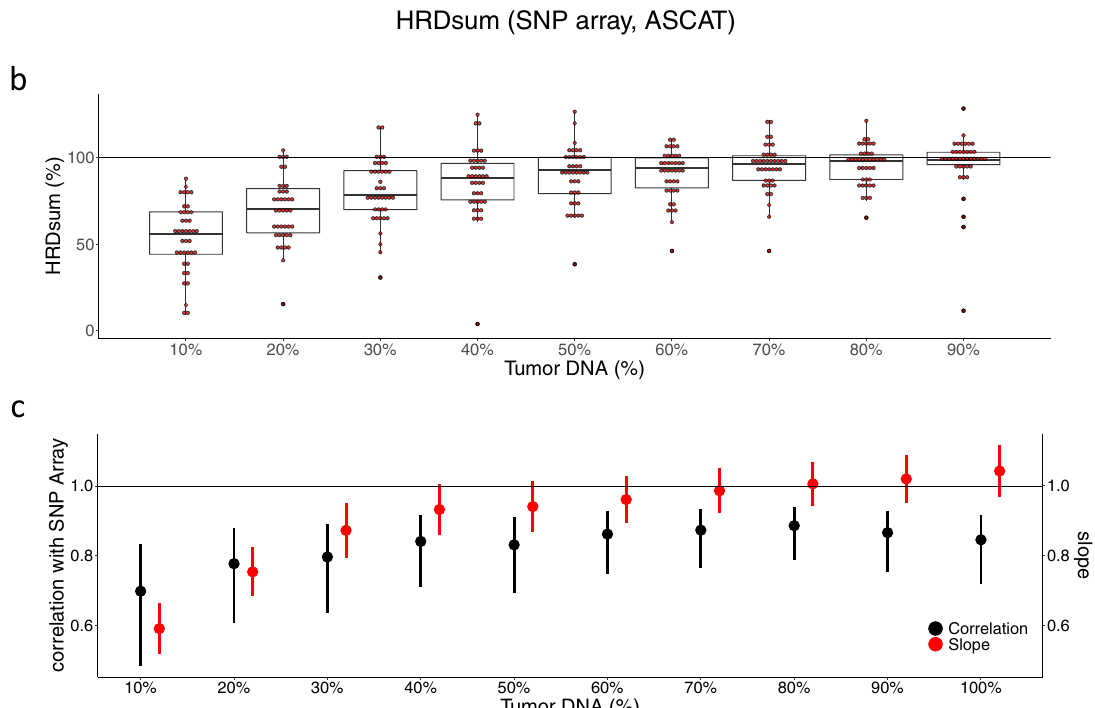
Fig. 6 Validation of HRDsum scores calculated from WES for the TCGA ovarian carcinoma cohort. a Correlation of HRDsum between WES and SNP array data. Each tumor is colored according to the HRR gene mutation class H1-H3. Linear fi t with intercept fi xed at zero. R = Pearson correlation. b/c Analysis of the in fl uence of tumor purity on determination of HRDsum by WES. In silico dilution series including 10%, … , 100% reads from the tumor DNA samples and 90%, … , 0% of the reads from the normal DNA samples. b HRDsum scores of the diluted samples expressed as percentages of the corresponding undiluted samples. Box-plot elements show the 5%, 25%, 50%, 75% and 95% quantile of the distribution of HRD scores. c Comparison between HRDsum scores of WES and SNP arrays by Pearson correlations and by fi tting linear models without intercepts fi xed at zero. Pearson correlations and slopes are shown including 95% con fi dence